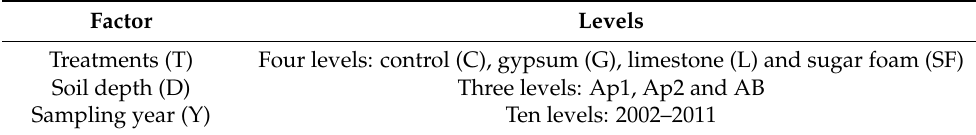
Table 2. Factors and levels by the factors considered in mixed ANOVAs. Factor Levels Treatments (T) Four levels: control (C), gypsum (G), limestone (L) and sugar foam (SF) Soil depth (D) Three levels: Ap1, Ap2 and AB Sampling year